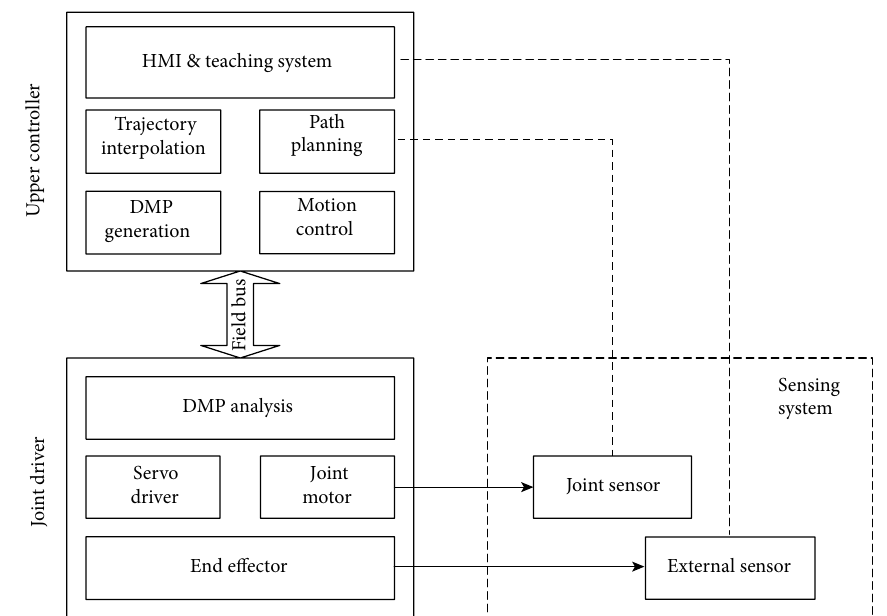
Figure 4: The structure of controller system with modularized component.